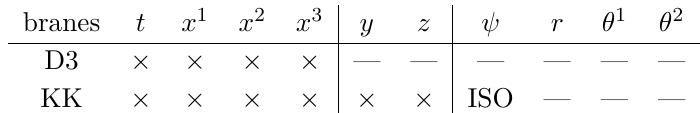
Table 3 . Brane system corresponding to the D3-KK intersection. The S 5 in the near horizon of the D3 branes is broken into the Lens space S 5 / Z back the D4-NS5 system depicted in table